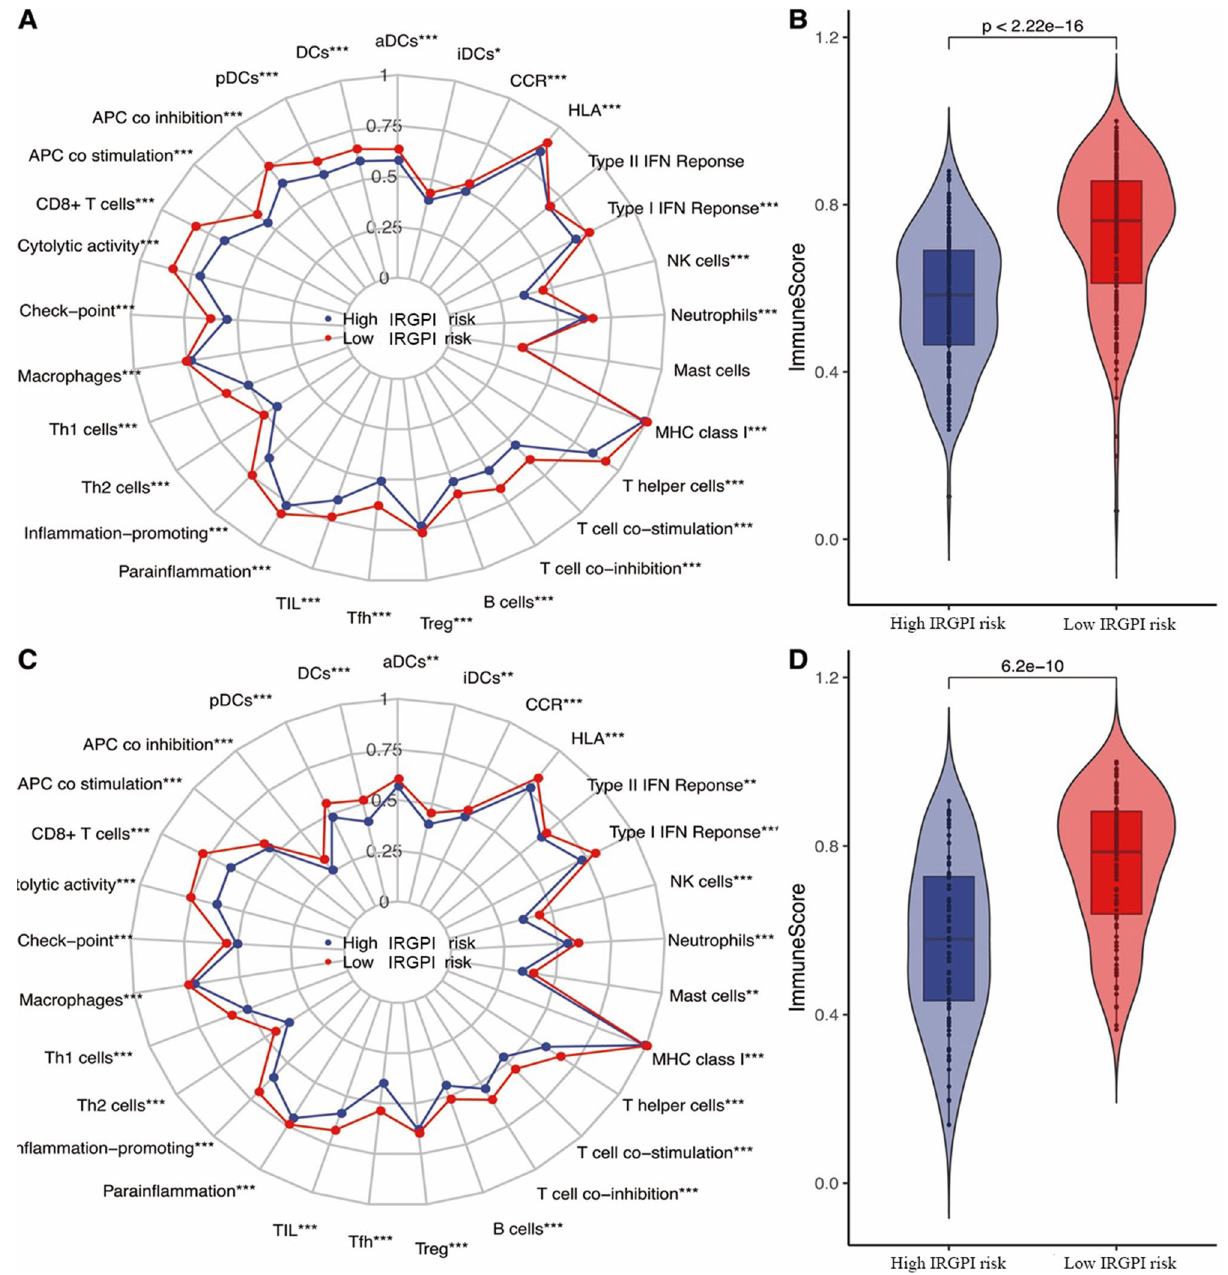
Figure 5. Tumor immune microenvironment status within differential immune risk groups by using ssGSEA. ( A ) Summary of the 29 immune cells score of differential immune risk groups in training cohort. ( B ) The total immune score of differential immune risk groups in training cohort. ( C ) Summary of the 29 immune cells score of differential immune risk groups in testing cohort. ( D ) The total immune score of differential immune risk groups in testing cohort. All p values were estimated by t test (* p < 0.05, ** p < 0.01, *** p <